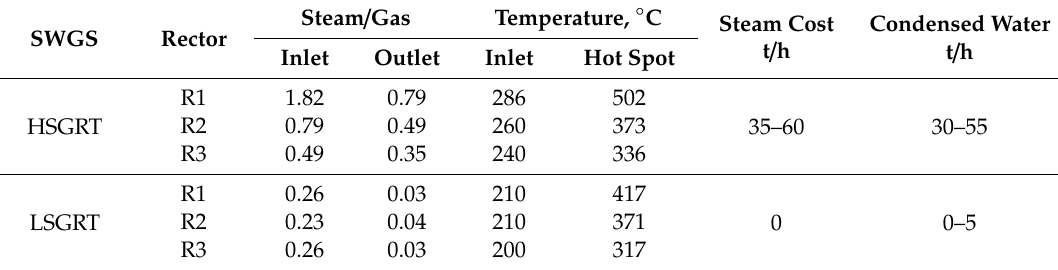
Condensed Water t / h t / hInlet Outlet Inlet Hot Spot 35–60 30–55R2 0.79 0.49 260 373